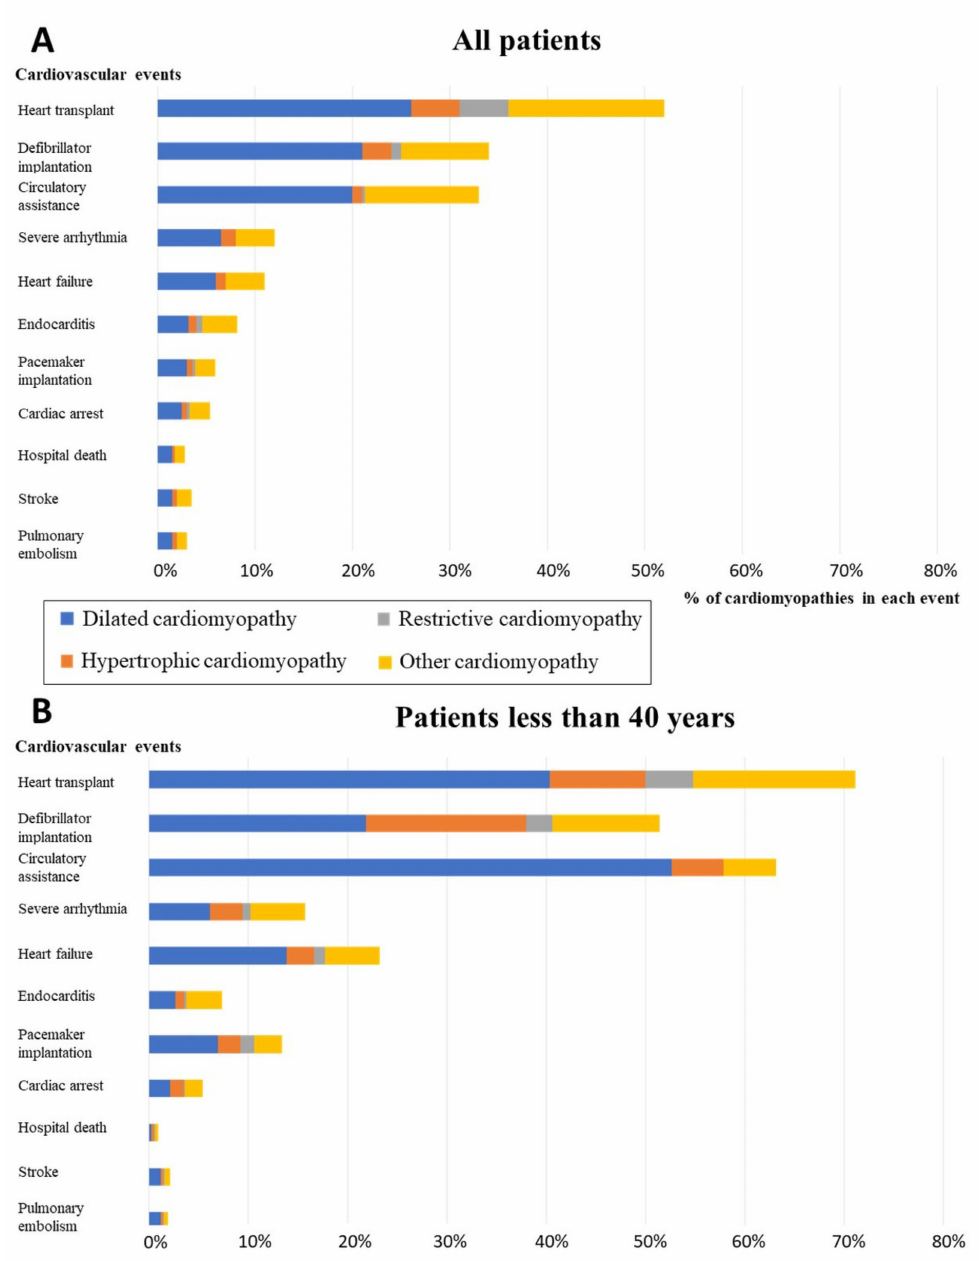
Figure 2. Proportion of patients with cardiomyopathies among all patients hospitalized for at least one major cardiovascular event or invasive therapeutic procedure in 2015. A . Proportions in the total population. B . Proportion in the subgroup of patients less than 40 years of age. Cardiac arrest: includes codes for sudden death, cardiac arrest, and aborted cardiac